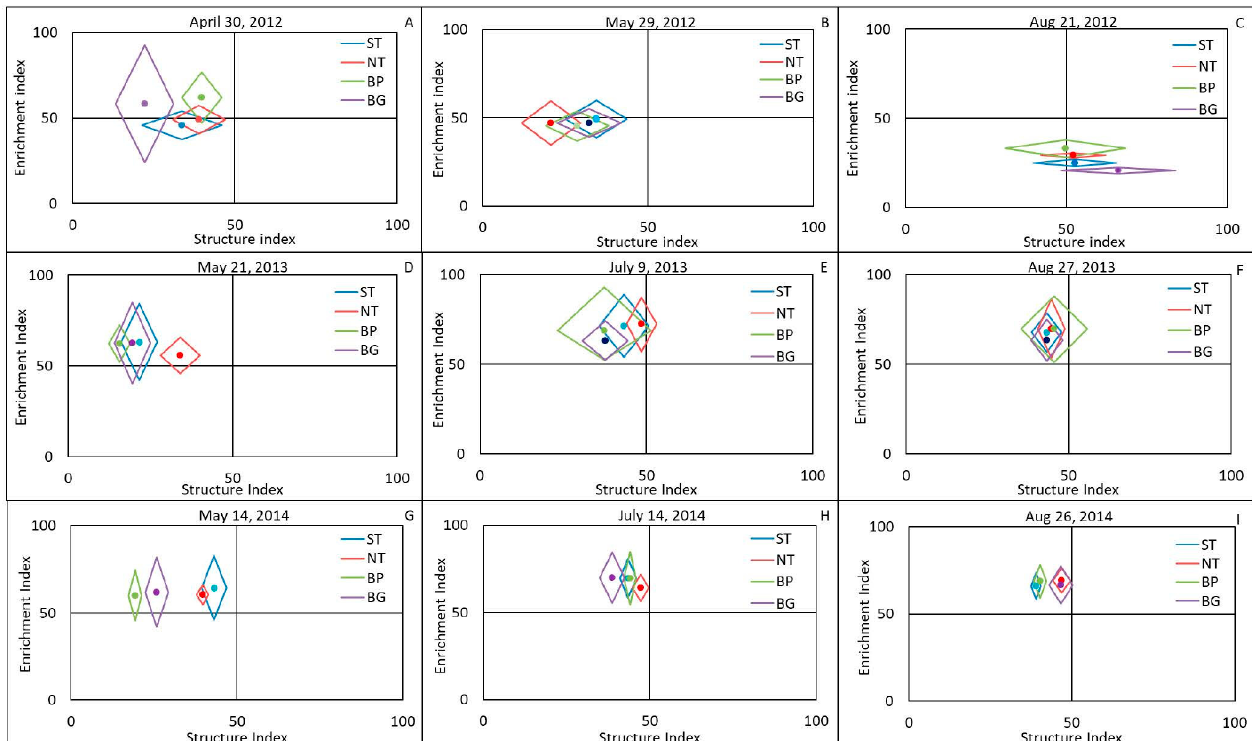
Figure 1. The functional metabolic footprints of soil food webs from each sampling date in 2012 ( A – C ), 2013 ( D – F ), and 2014 ( G – I ) field trials. The vertical axis of each footprint represents the enrichment footprint and horizontal axis represents the structure footprint. BG = Bare ground (Conventional till without mulch), BP = Conventional till with black plastic, NT = no-till, ST = strip-till.